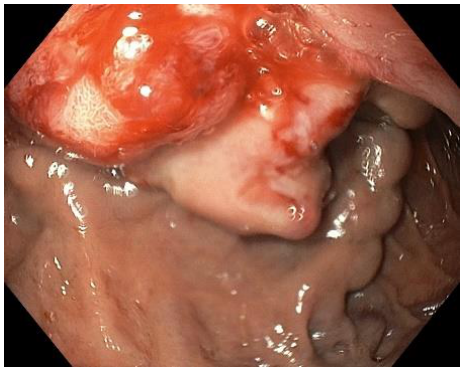
Figure 1. Esophago-gastro-duodenoscopy: duodenal variceal bleeding. A bidimensional transthoracic Doppler echocardiography (TTE) exam was per-